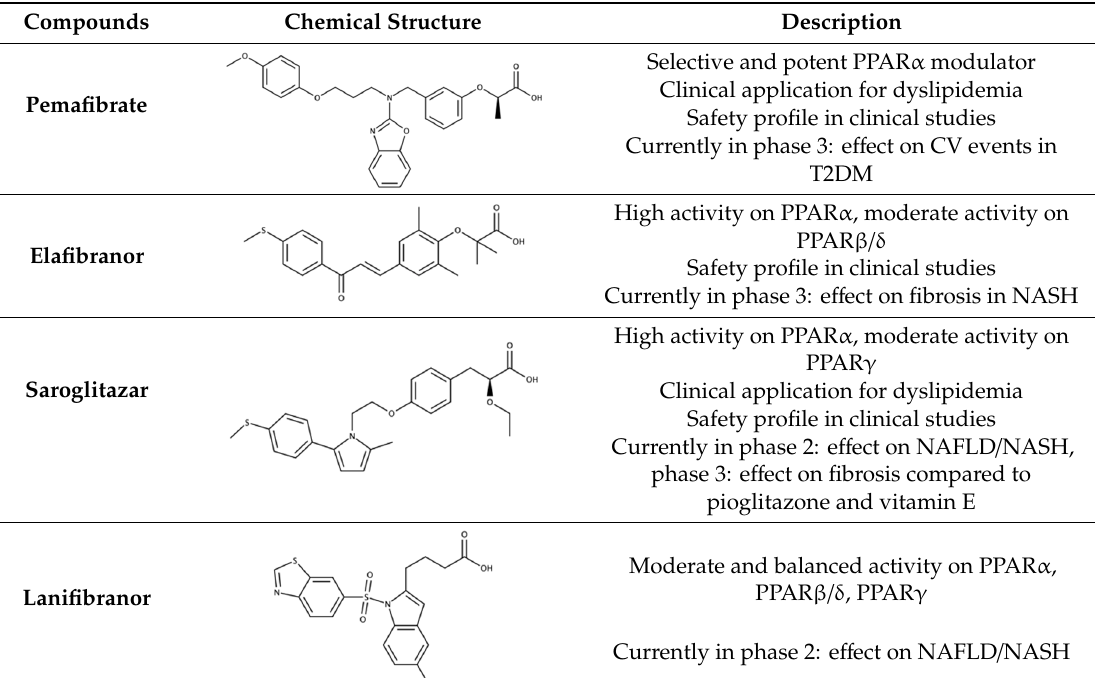
Table 2. PPAR agonists currently in late-stage clinical trials (phase 2 and phase 3). Overview of new PPAR agonists: trivial name, chemical structure, and short description.